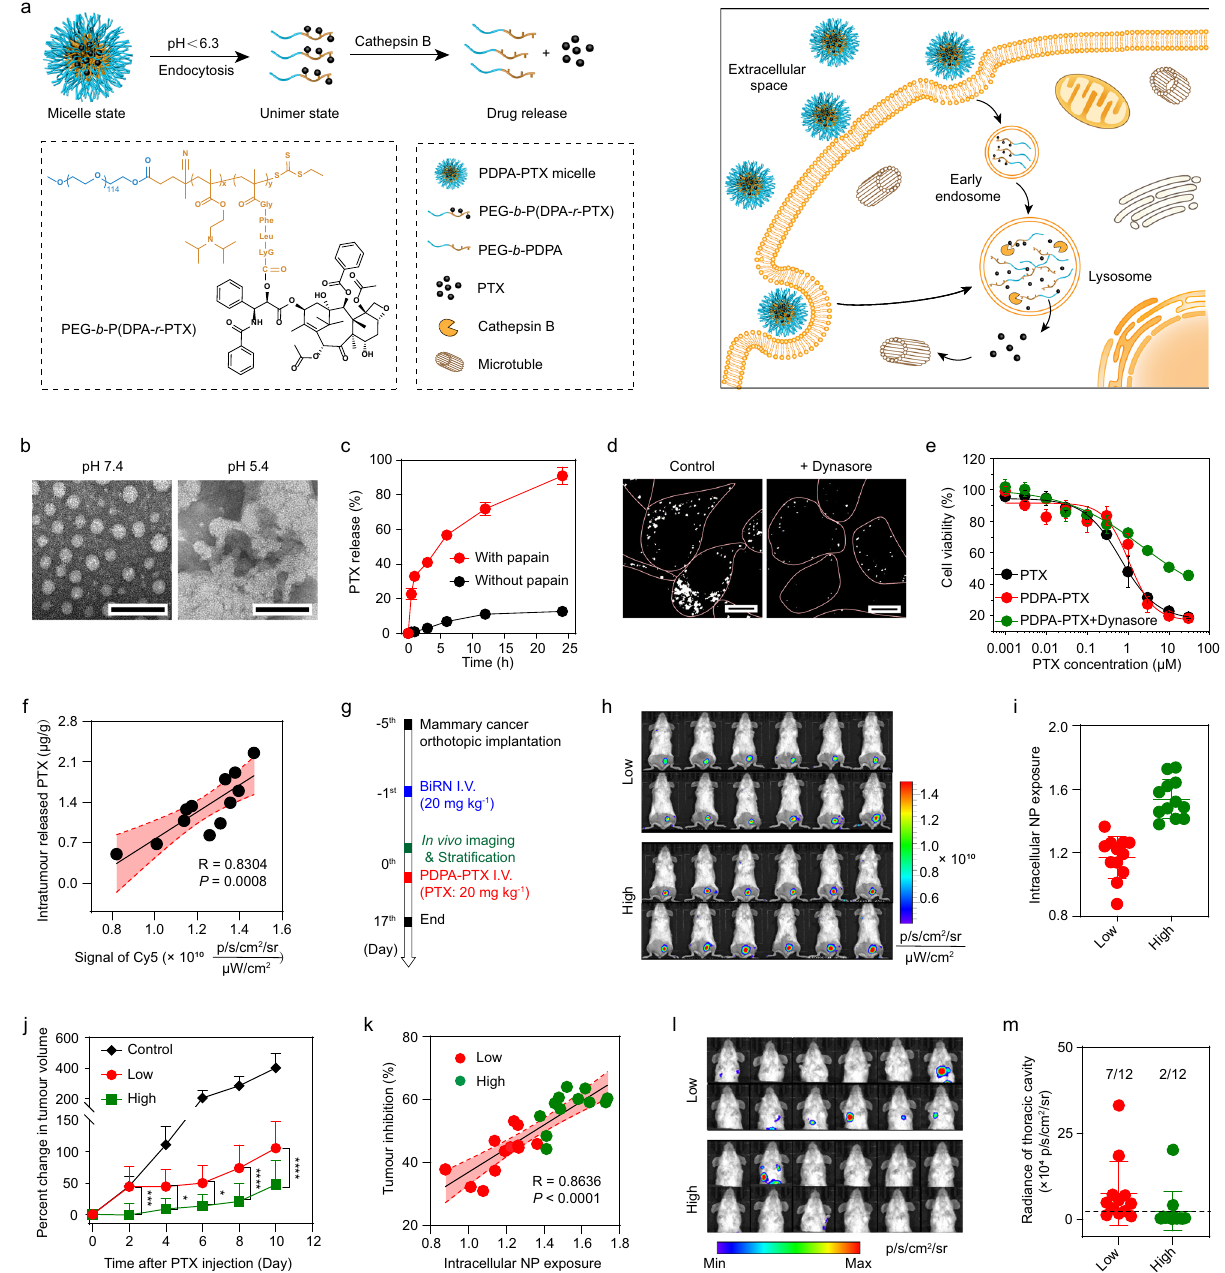
Fig. 5 BiRN predicts therapeutic ef fi cacy of PDPA-PTX nanoparticle. a The design of PDPA-PTX and schematic of internalisation and PTX release of PDPA-PTX in cells. b TEM images of PDPA-PTX at pH 7.4 and 5.4. Polymer concentration, 1 mgmL − 1 , scale bar, 100 nm. c In vitro PTX release pro fi les of PDPA-PTX in different conditions. Mean ±s.d. (n = 3 biologically independent experiments). d Confocal images of 4T1 cells treated with BiRN (100 μ g mL − 1 ) with or without dynasore. e Cytotoxicity of free PTX and PDPA-PTX micelle. Mean ±s.d. ( n = 6 biologically independent experiments). f Correlation between intracellular nanoparticle exposure and intratumoural levels of released PTX at 48h post-injection of BiRN and PDPA-PTX (PTX, 10mg kg − 1 ). R and P values were derived using a simple linear regression model. The error band in red shows the 95% con fi dence intervals of the fi tted line by two-sided Student t -test analysis. g Experimental design for using BiRN to predict PDPA-PTX response in 4T1 orthotopic tumour model. h Fluorescence images of 4T1 tumour-bearing mice were captured at 24h post-injection of BiRN (20mgkg − 1 ) ( n = 24 biologically independent mice). i Intracellular nanoparticle level of 4T1 orthotopic tumour-bearing mice in h . Mean ± s.d. ( n = 24 biologically independent mice) j Tumour progression in 4T1 orthotopic tumours ranked according to low and high internalisation. *** P = 0.0005 at day 2, * P = 0.0123 at day 4, * P = 0.0411 at day 6, **** P < 0.0001 at day 6 and day 8, Two-way analysis of variance (ANOVA). Mean ±s.d. ( n = 9 mice for PBS group; n = 12 for other groups). k Correlation between intracellular nanoparticle level and 4T1 tumour progression presented as tumour inhibition percentage ( n = 24 biologically independent mice). R and P values were derived using a simple linear regression model. The error band in red shows the 95% con fi dence intervals of the fi tted line by two-sided Student t -test analysis. l Lung metastases imaged by in vivo BLI analysis. m Quantitative analysis of mice thoracic cavity signal in l ( n = 12 biologically independent